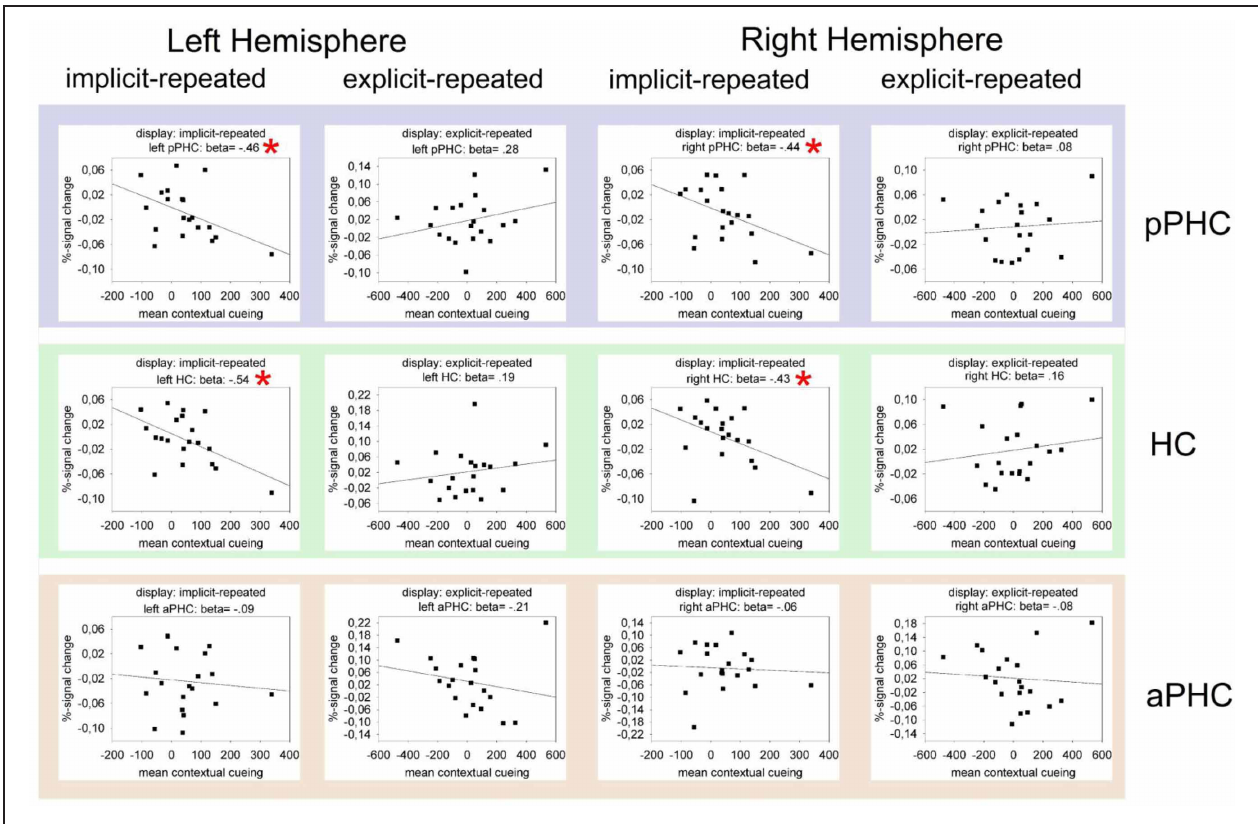
FIGURE 4 | Mean percentBOLD signal changeas a functionofcontextual cueing(estimated as theRTdifference between repeatedand non-repeateddisplays) inthecritical ROIs (pPHC,HC, andaPHC; top, middle, andbottompanel, respectively) of theleft andrighthemisphere.